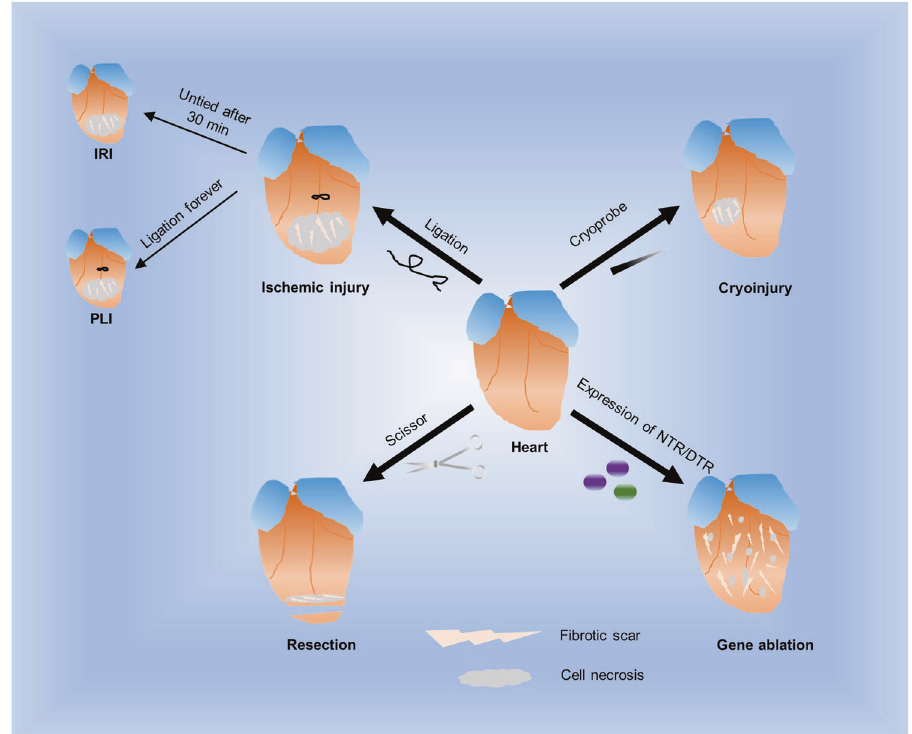
Fig. 1 Types of cardiac tissue injury. Ischemia-reperfusion injury (IRI), permanent ligation injury (PLI), cryoinjury, resection, and gene ablation are the four main ways of studying cardiac injury and repair. IRI is used to simulate the pathological state of myocardial infarction (MI). The ligation is untied and blood reperfusion is performed after ligation of the mouse artery for 30 min Cryoinjury is caused by cauterization of ventricular tissue with a cryoprobe. Resection is used to surgically remove part of the cardiac tissues. The gene ablation method speci fi cally expresses bacterial nitroreductase (NTR) or diphtheria toxin receptor (DTR) in cardiomyocytes (CMs) to result in CM